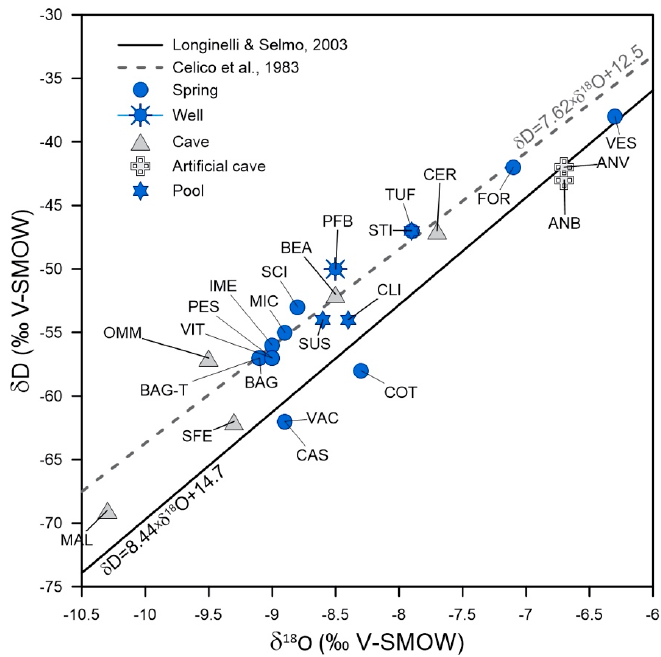
Figure 7. Plot of δ 18 O vs δ D of water measured in the samples; the reference lines by Celico et al. [37] for groundwater and Longinelli and Selmo [38] for rainwater of Central Italy are also reported. The most probable source of sulphate is the dissolution of the Triassic evaporites over which the carbonate sequence lay; this is demonstrated by the binary diagram SO 4 -Ca* (Figure 4), which indicates that calcium not linked to the dissolution of calcite and dolomite is in a stoichiometric and Ca*, the better their correlation is, and at the opposite sides of the line there are water samples